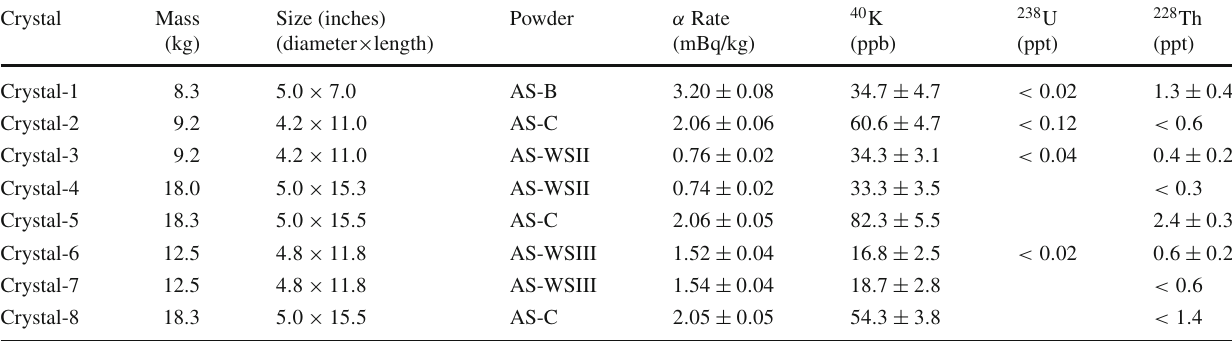
Fig. 1 Front ( a ) and Side ( b ) views of the detector geometry used in the Geant4 simulations. From outside inward, the four shielding layers include: 3 cm thick plastic scintillator panels (dark blue), 20 cm lead (pink), 3 cm copper box (light green), and liquid scintillator (not shown) Table 1 Radioactive contamination levels in the COSINE-100 crystals reported in Ref. [7]. These were used as inputs when fitting the simulations to the data. The 238 U and 232 Th decays were assumed to be in